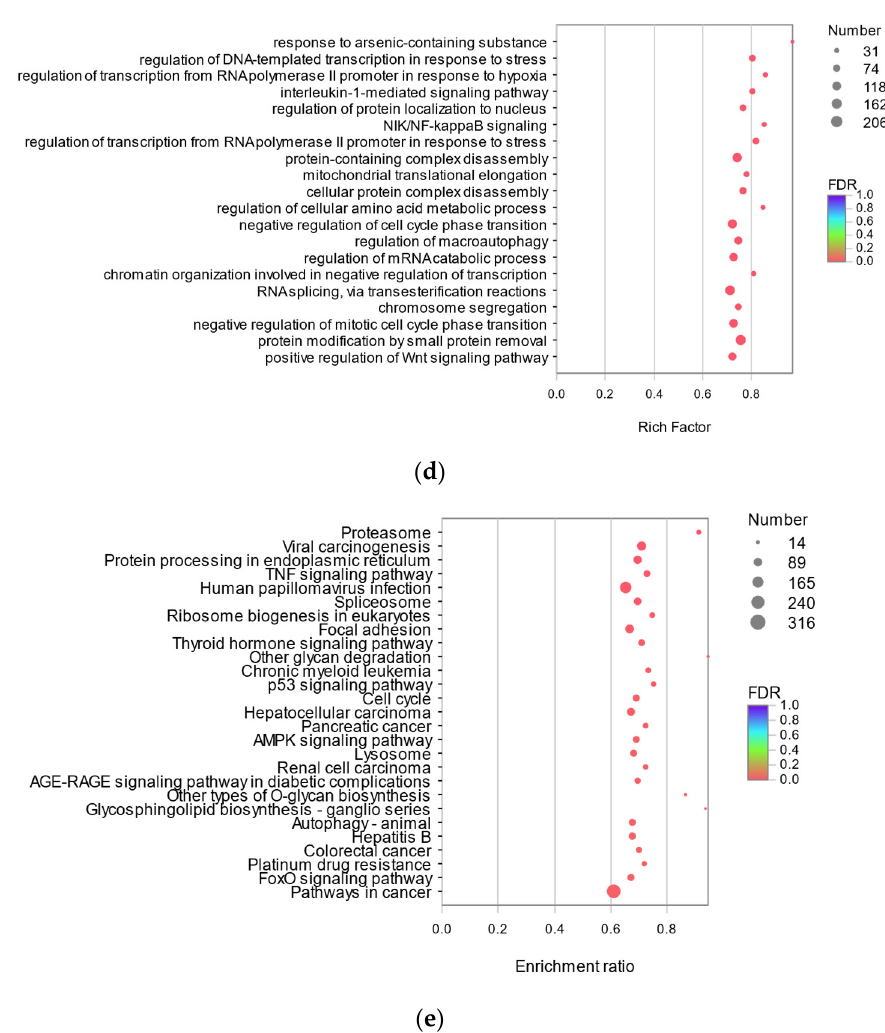
Figure 5. Transcriptome sequencing analysis: ( a ) principal component analysis (PCA); ( b ) differen- tially expressed genes between control and model groups; ( c ) differentially expressed genes between model and RFP groups; ( d ) results of GO functional enrichment of the differentially expressed genes of three groups; and ( e ) results of KEGG functional enrichment of the differentially expressed genes of three groups.